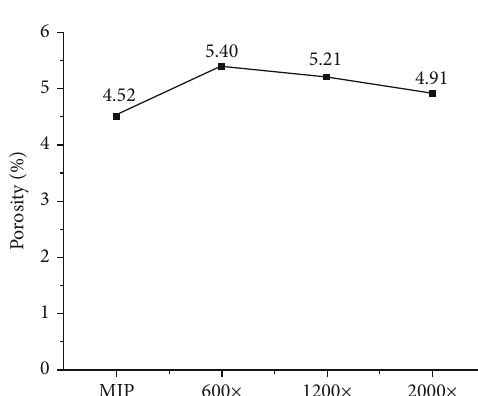
Figure 7: Porosity calculation results based on digital images and